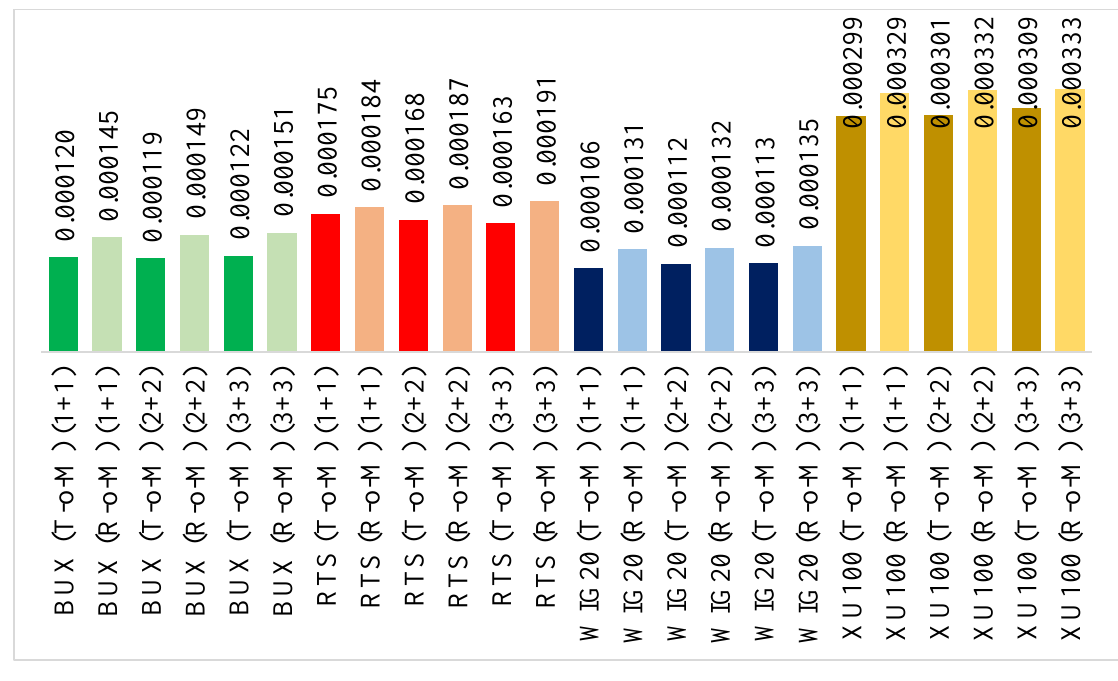
Figure 5. Comparison of average daily volatilities (alternative 2).